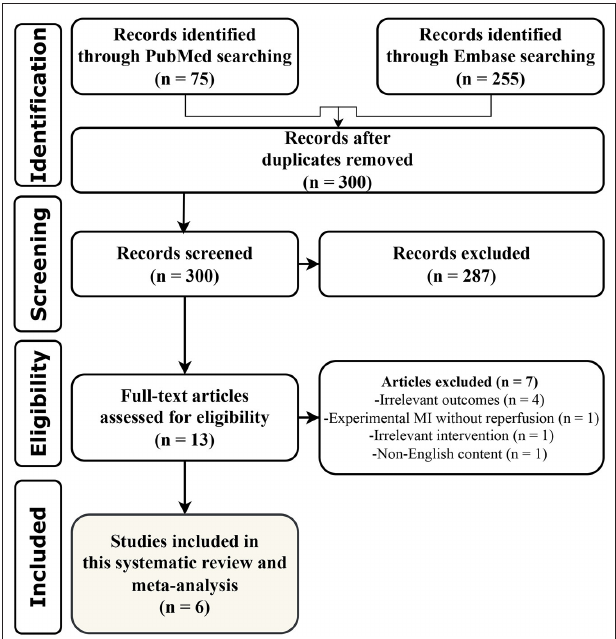
FIGURE 1 | PRISMA flow diagram of study screening and selection process. MI, myocardial infarction.